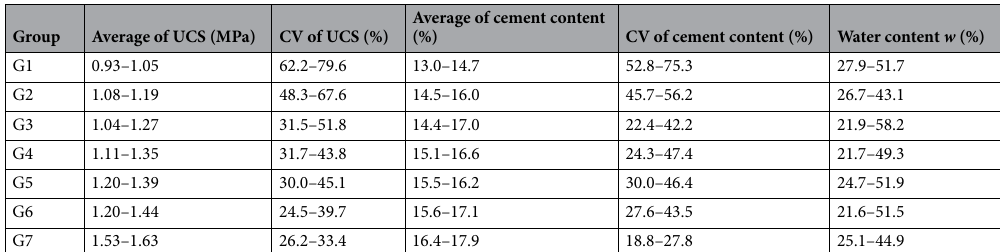
Table 5. Average and CV of UCS and cement content of single